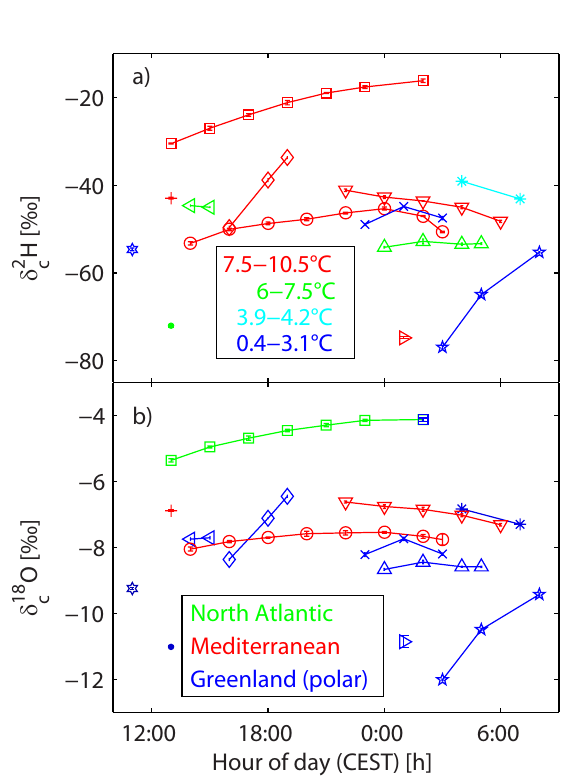
Fig. 3. Diurnal evolution (shown from 10:00am to 10:00am next day) of the δ 2 c H and δ 18 c O values (including measurement uncer- tainty Eq. 3) for all measured cloud events during HCCT-2010: The different cloud events are represented with different symbols as summarized in Table 1. Different colors represent (a) the temper- ature range and (b) the predominant air mass during the cloud event as classified by Tilgner et al.